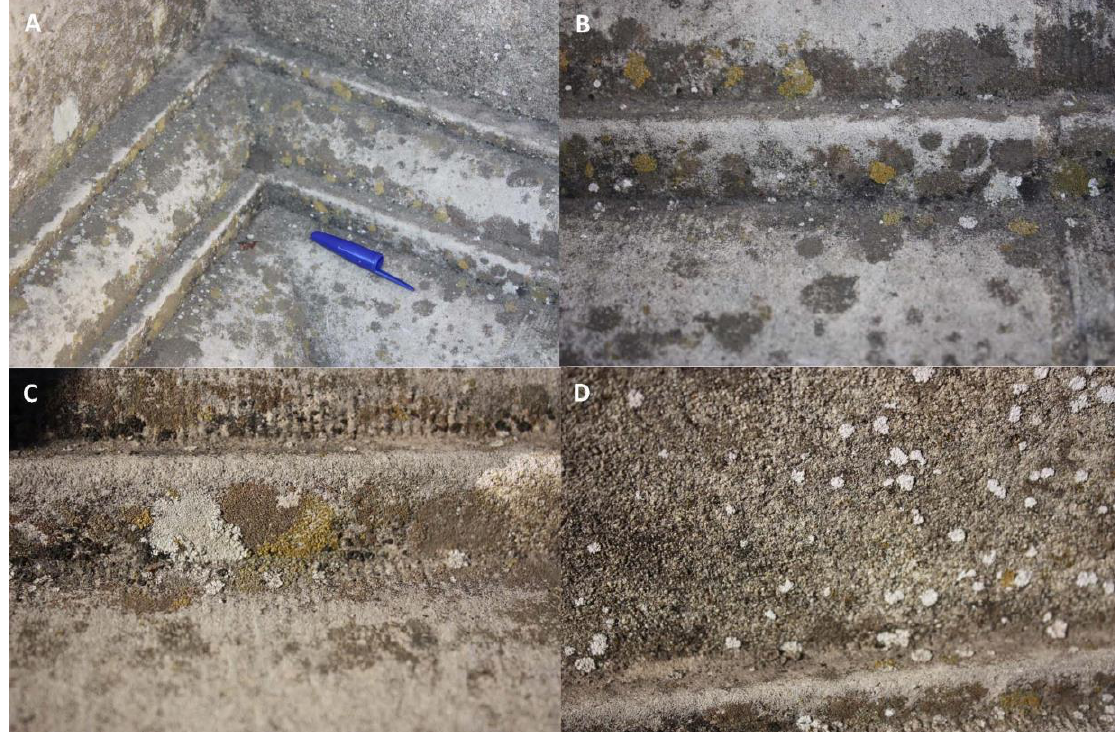
Figure 7. Lichen communities on the City Hall façade, close to the Cross of the Inquisition. ( A ) Com- munity dominated by Pyrenodesmia variabilis . ( B ) Same community with Caloplaca citrina group species. ( C ) Community of Pyrenodesmia variabilis , Caloplaca citrina group species and Kuettlingeria teicholyta . ( D ) Community with Kuettlingeria teicholyta .